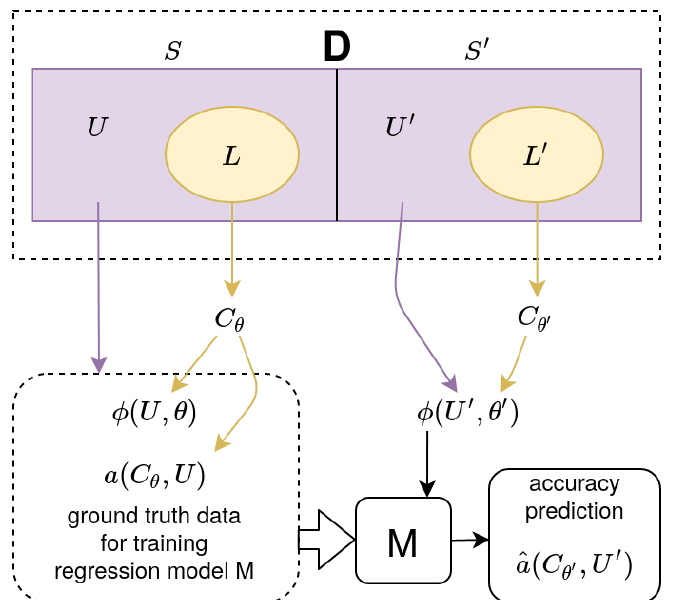
Figure 2. A domain D contains data pools S , S (cid:48) . To predict (predictor M ) the accuracy of a classifier ( U (cid:48) ) while incrementally trained on pool L (cid:48) (querying labels from U (cid:48) , moving samples to L (cid:48) , C θ (cid:48) right side), we first create from another instance C ( S , θ ) of the same classifier, but incrementally trained on a “training pool” S (with label queries from L , left side), ground-truth data for a regression model M . This regression model captures the relationship between classifier confidences (“configrams”) φ and accuracies a on its training pool S . Once the model has been formed, it can be used to generalize this relationship to the new pool S (cid:48) allowing accurate prediction of the accuracy of incremental